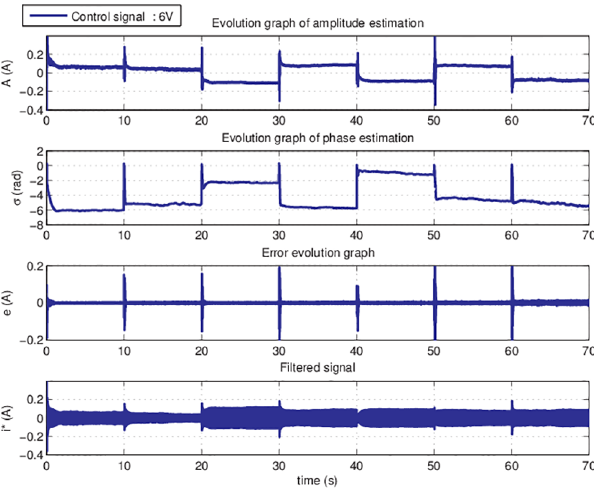
Fig 14. Parameters estimation graph for entire set of harmonics for